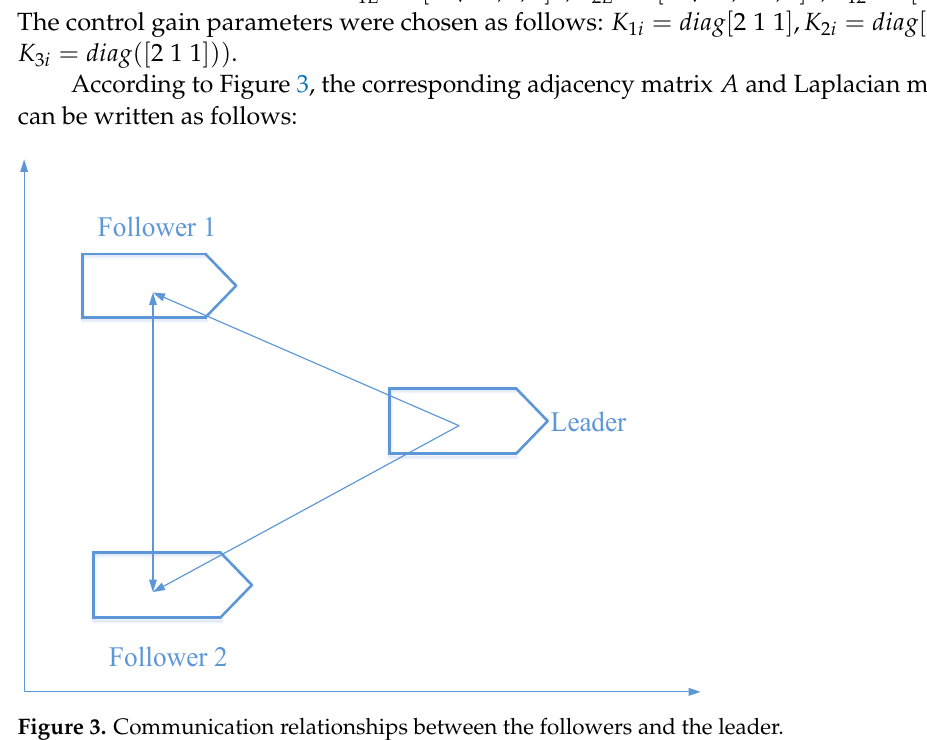
Figure 3. Communication relationships between the followers and the